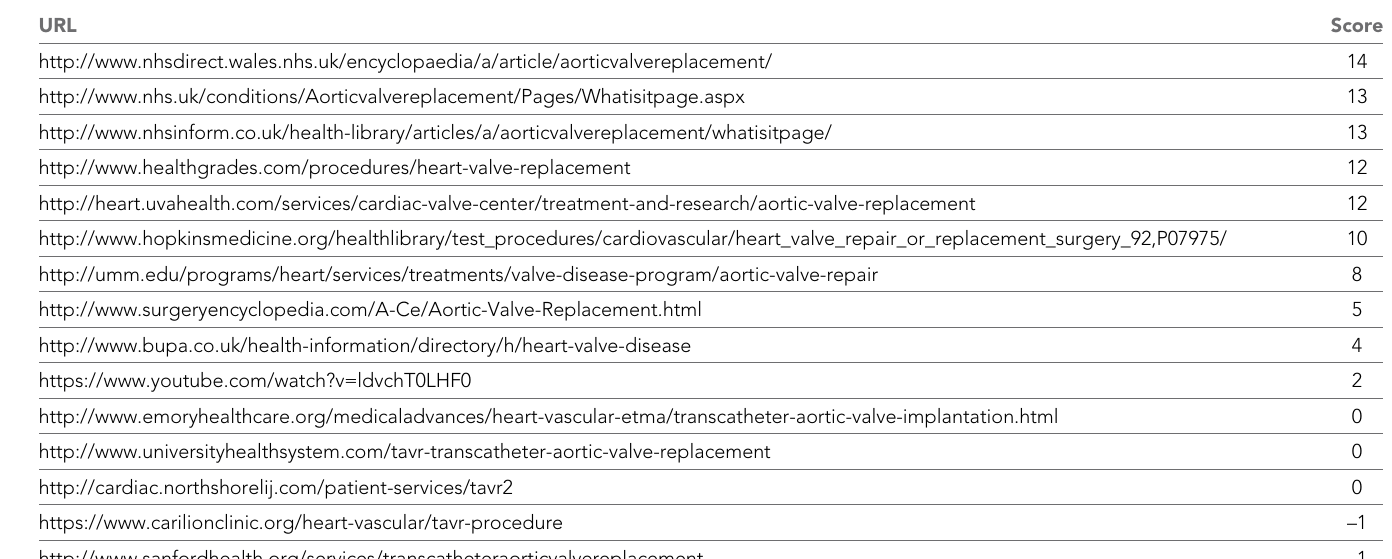
Table 1. Scores achieved by a sample of websites assessed